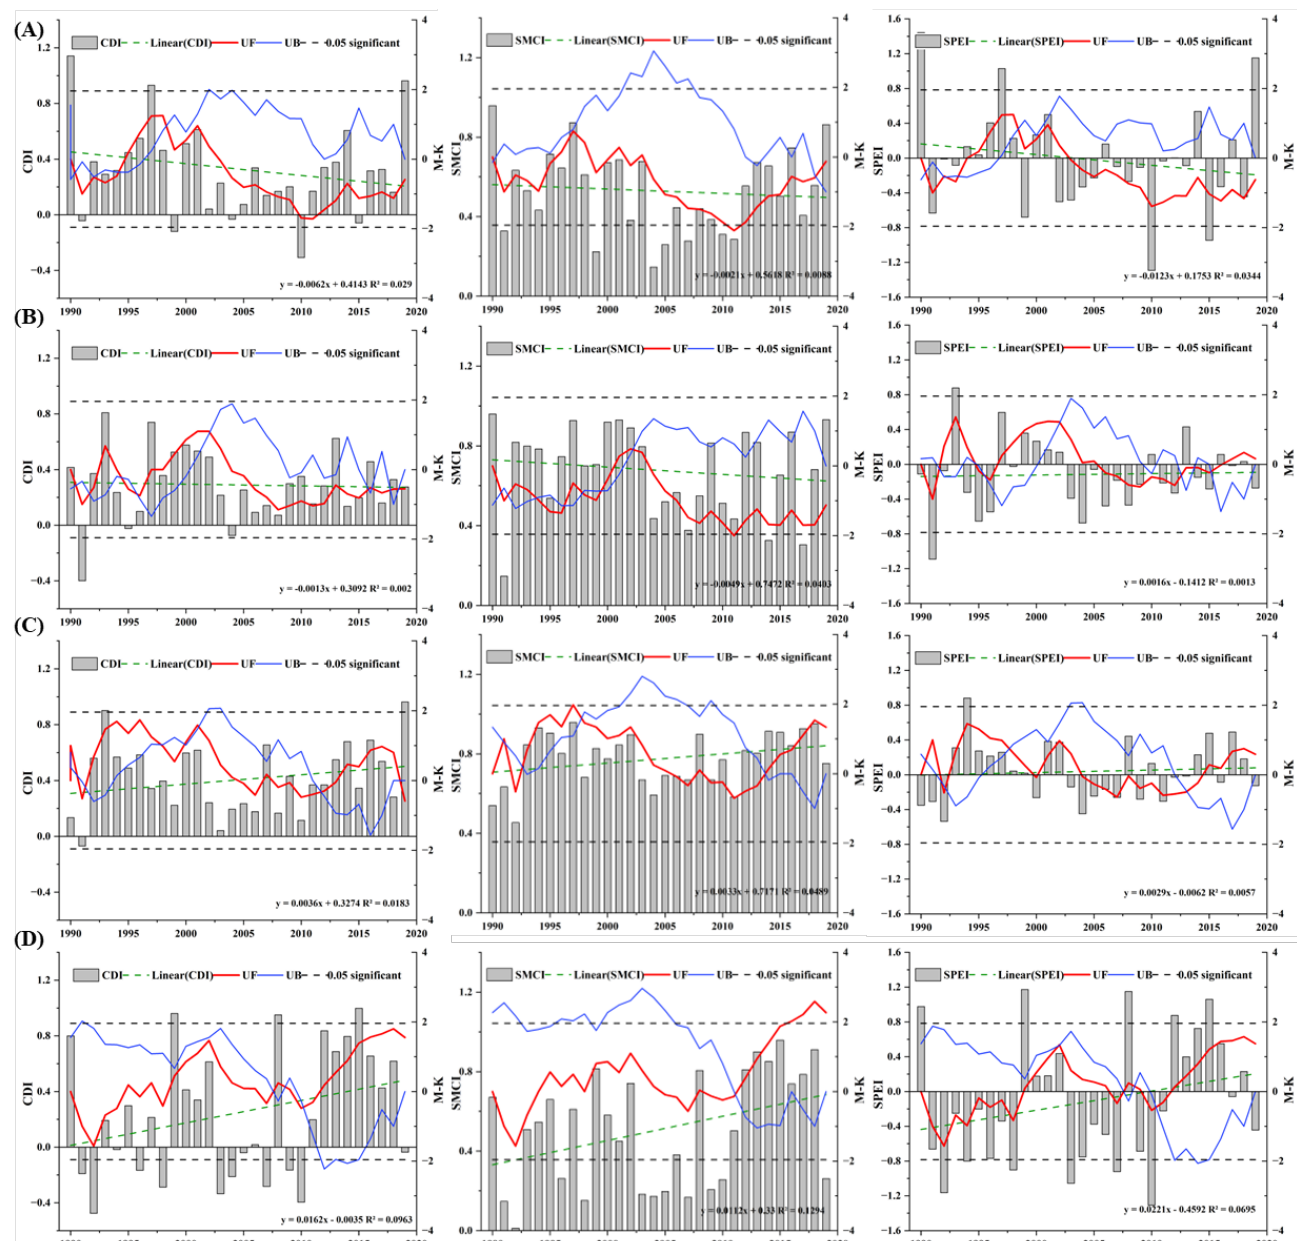
Figure 4. Trends of CDI , SPEI , and soil moisture condition index ( SMCI ) of sugarcane in Guangxi Province at the different time scales. ( A – D ) refer to the growth stages of seedling emergence, tillering, stem elongation, and maturity, respectively.